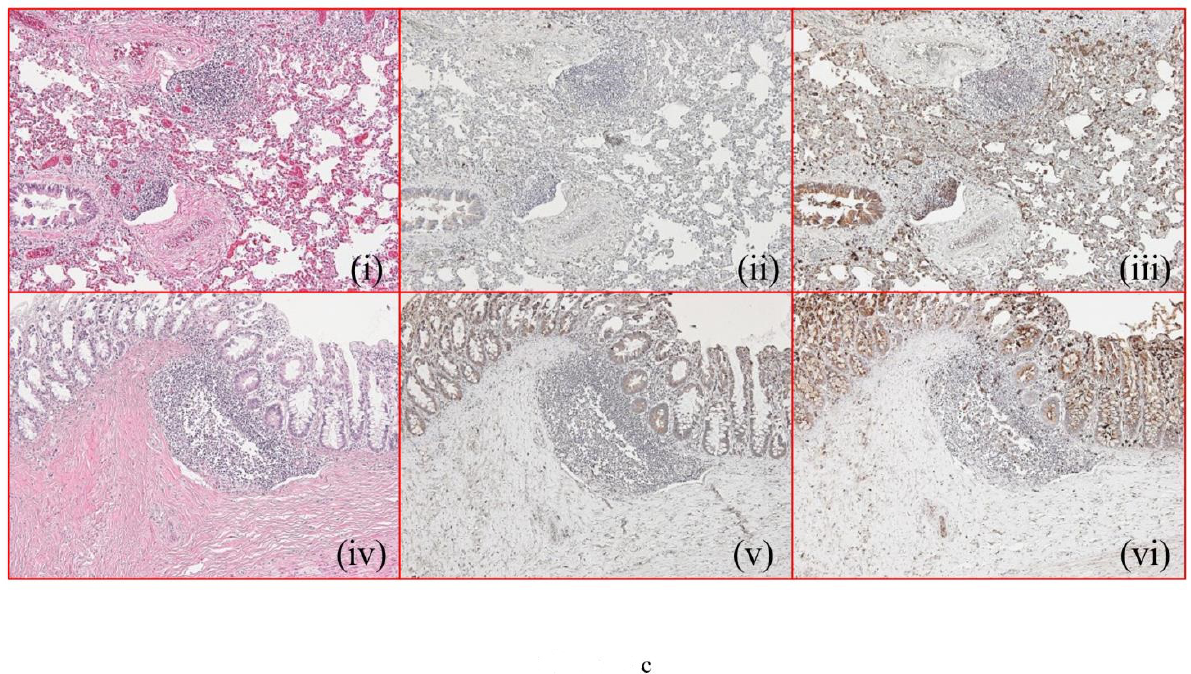
Figure 2. Histopathology of pulmonary hilar lymph nodes and intestinal Peyer’s patches in ( a ) non-infection, ( b ) bacterial infection, and ( c ) viral infection autopsy cases. Pulmonary hilar lymph node: ( i ) HE staining (×100), ( ii ) IFNβ immunostaining (×100), ( iii ) IgA immunostaining (×100). Intestinal Peyer’s patches: ( iv ) HE staining (×100), ( v ) IFNβ immunostaining (×100), ( vi ) IgA immunostaining (×100). Table 3. Histopathology findings of pulmonary hilar lymph nodes and Peyer’s patch interstitial cells (-, negative; +, slight; ++, moderate; +++, strong) and results of lgA and IFNβ immunohisto- chemistry (1, slightly positive; 2, moderately positive; 3, strongly positive). Lung (Pulmonary Hilar (Peyer’s Patch) Lymph Node)